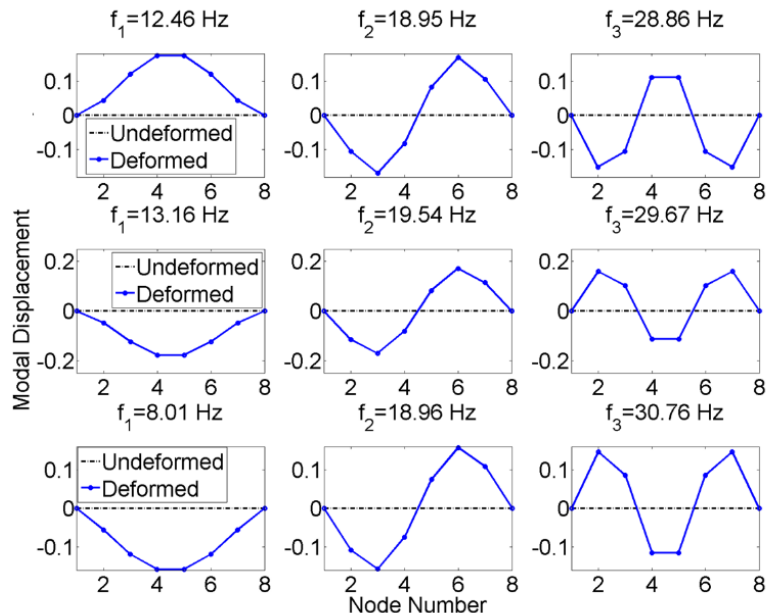
Figure 9. Updated FEM modal parameters for fixed-fixed, fixed-pinned, fixed-roller BCs.